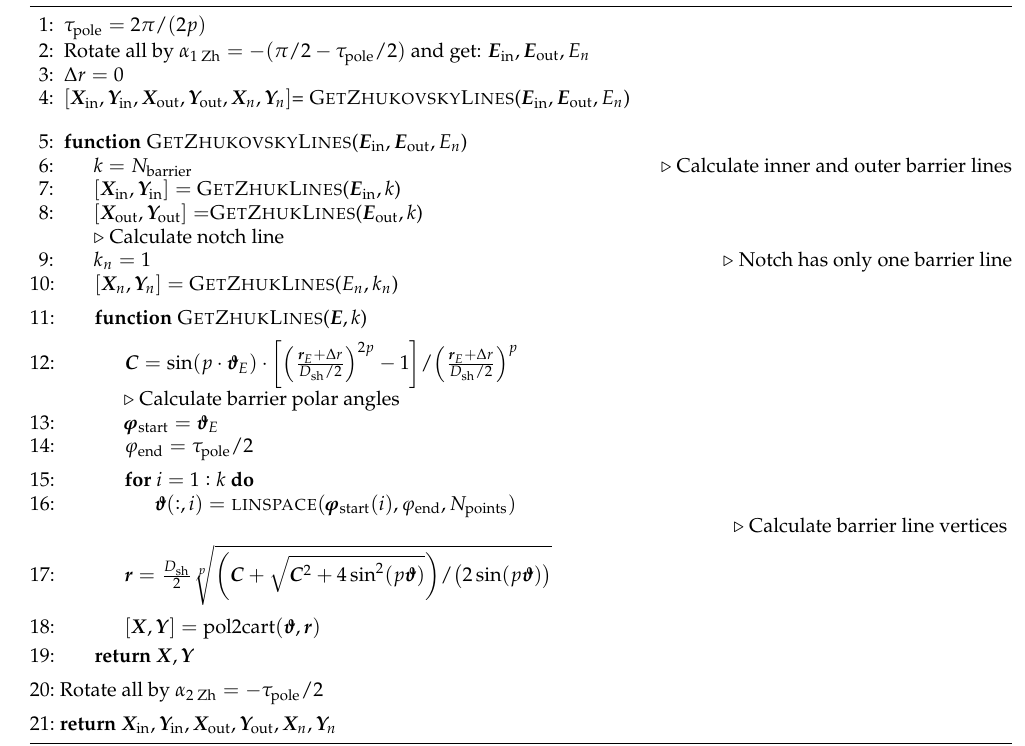
Algorithm 1 Construction of Zhukovsky